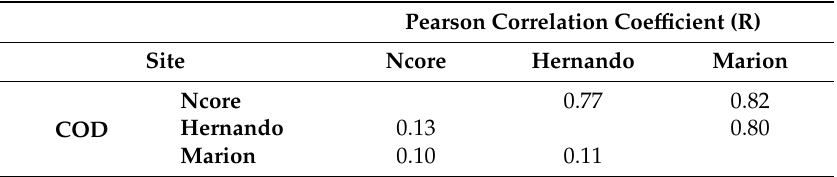
Table 2. Pearson correlation coe ffi cients (Rs) and coe ffi cients of divergence (CODs) of PM 2.5 concentrations among Ncore, Hernando, and Marion sites.